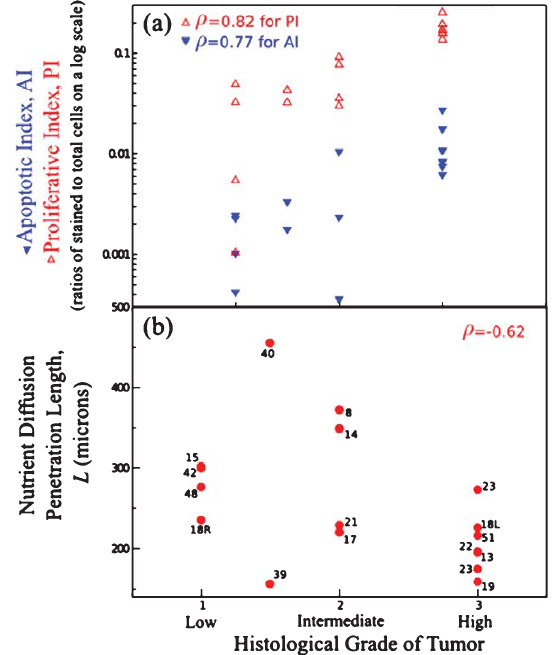
Fig. 4. Correlations of IHC and morphometric measurements with nucleargrade(withspearmanrankcorrelationcoefficients).(a)Aver- age apoptotic (AI) and proliferative (PI) indices for each tumor as increasing functions of (modified Black’s) nuclear grade (one overstained-AI tumor and one zero-AI tumor were excluded). (b) Nutrient diffusion penetration length L from average measured viable-rim thickness T in each tumor’s ducts is a decreasing function of nuclear